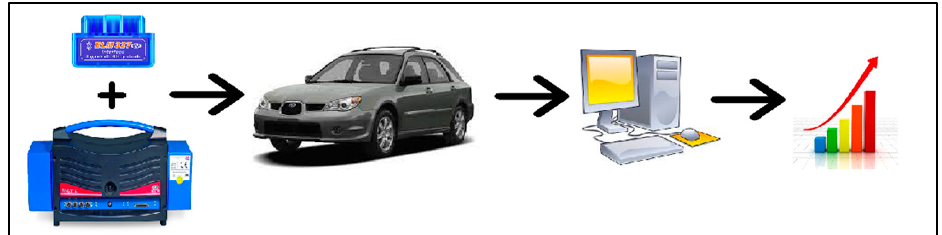
Figure 5. Schematic representation of the performed measurement.